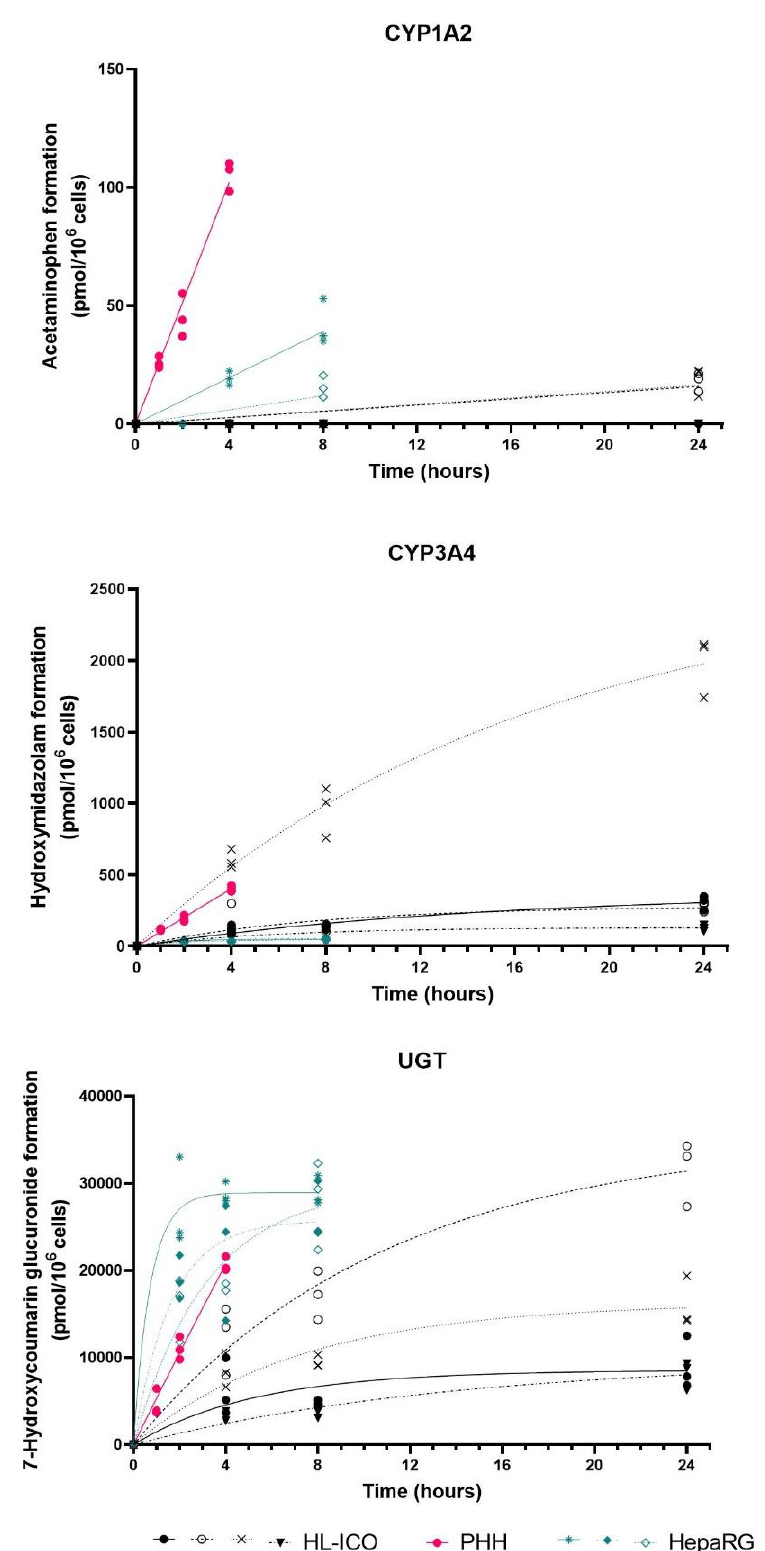
Figure 3. Metabolite formation as a measure of enzyme activity in hepatocyte-like intrahepatic cholangiocyte organoids (HL-ICOs) on differentiation day 12, primary human hepatocytes (PHHs), and HepaRG cells. HL-ICO: each black symbol indicates a different donor ( n = 4). HepaRG: Each green symbol represents an independent experiment. PHH: Technical triplicates are shown in pink.